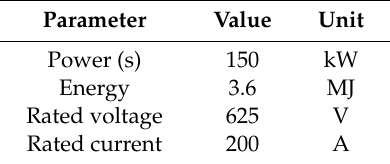
Table 3. Parameters of the ESS